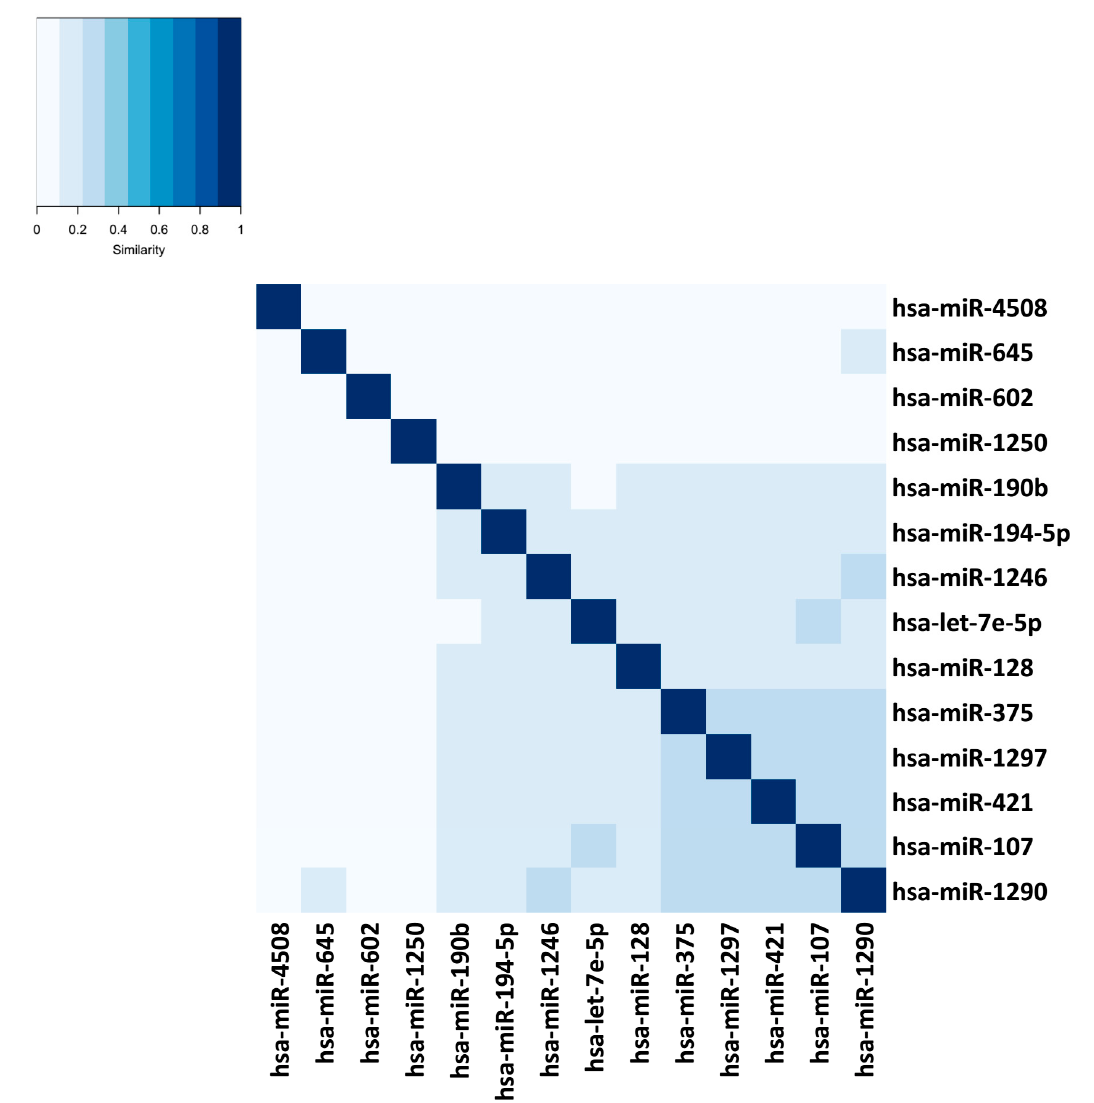
Figure 5. miRmapper output: identity plot with the miRNAs clustered by mRNA target similarity.